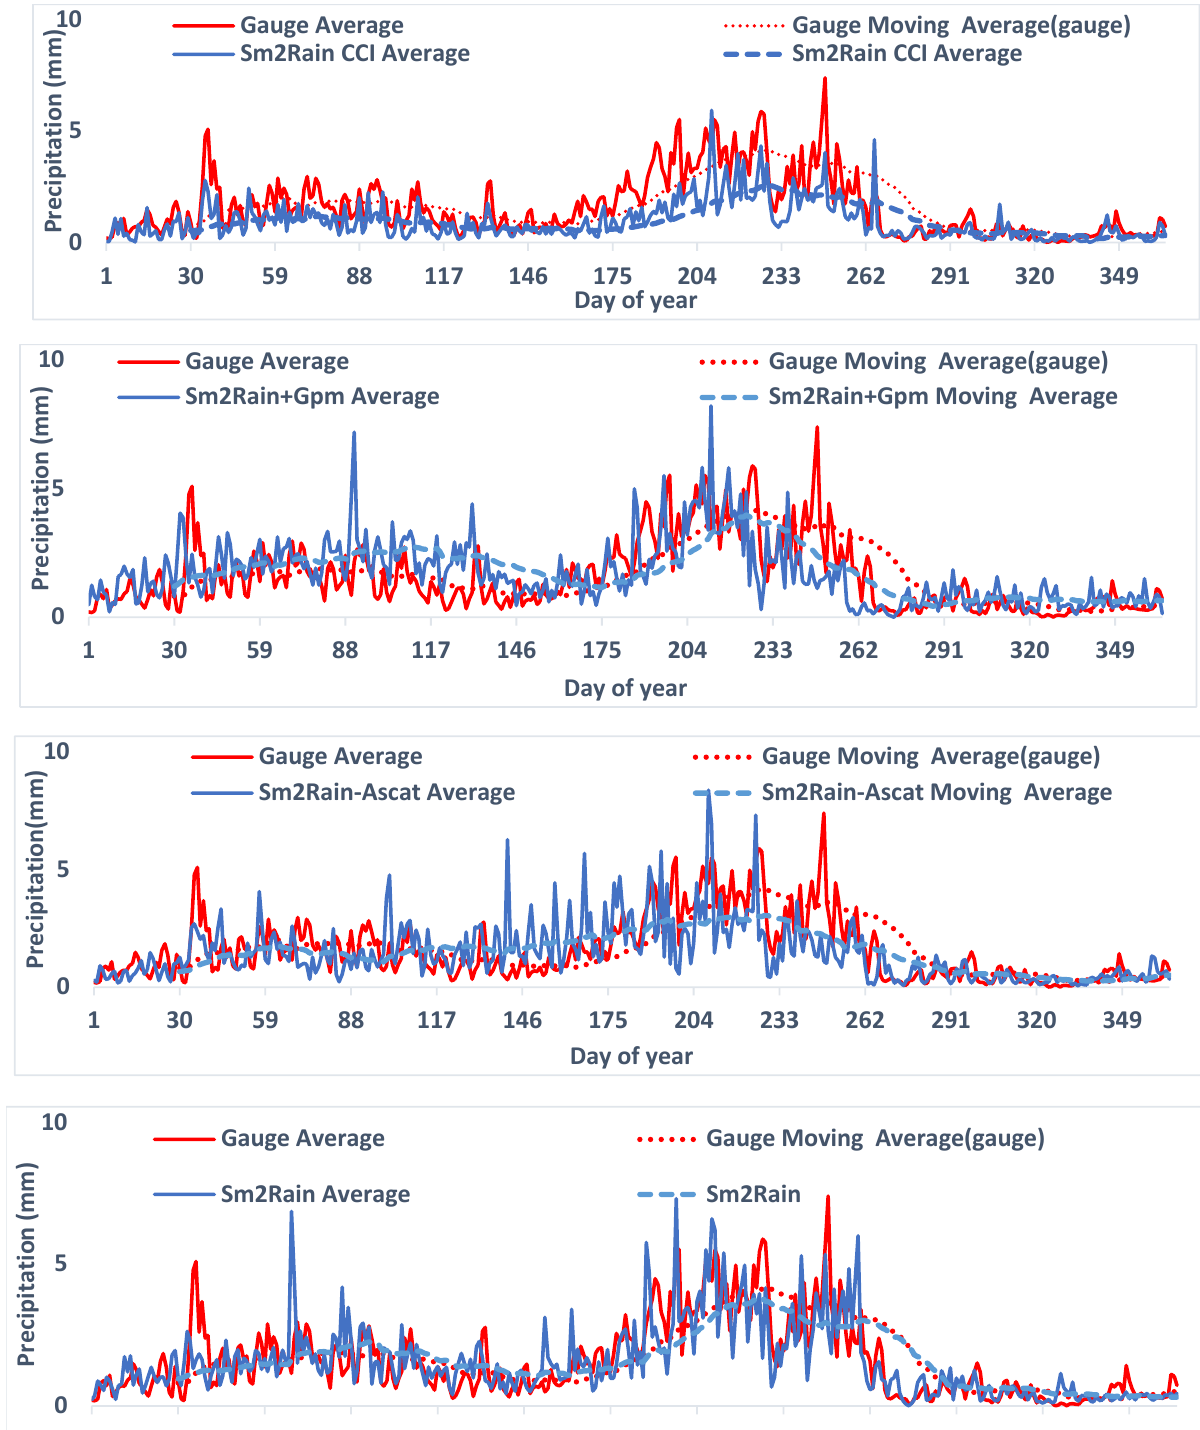
Figure 3. Comparison of spatial variability annual average precipitation of all SPPs.